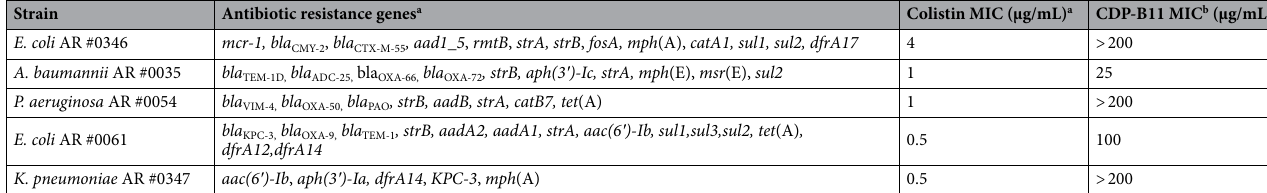
Table 1. AR isolate bank strains resistance genes and minimum inhibitory concentration (MIC) following CLSI guidelines. a Information from the Center for Disease Control Antimicrobial Resistance Isolate Database. https ://wwwn.cdc.gov/ariso lateb ank/. b Determined by the current